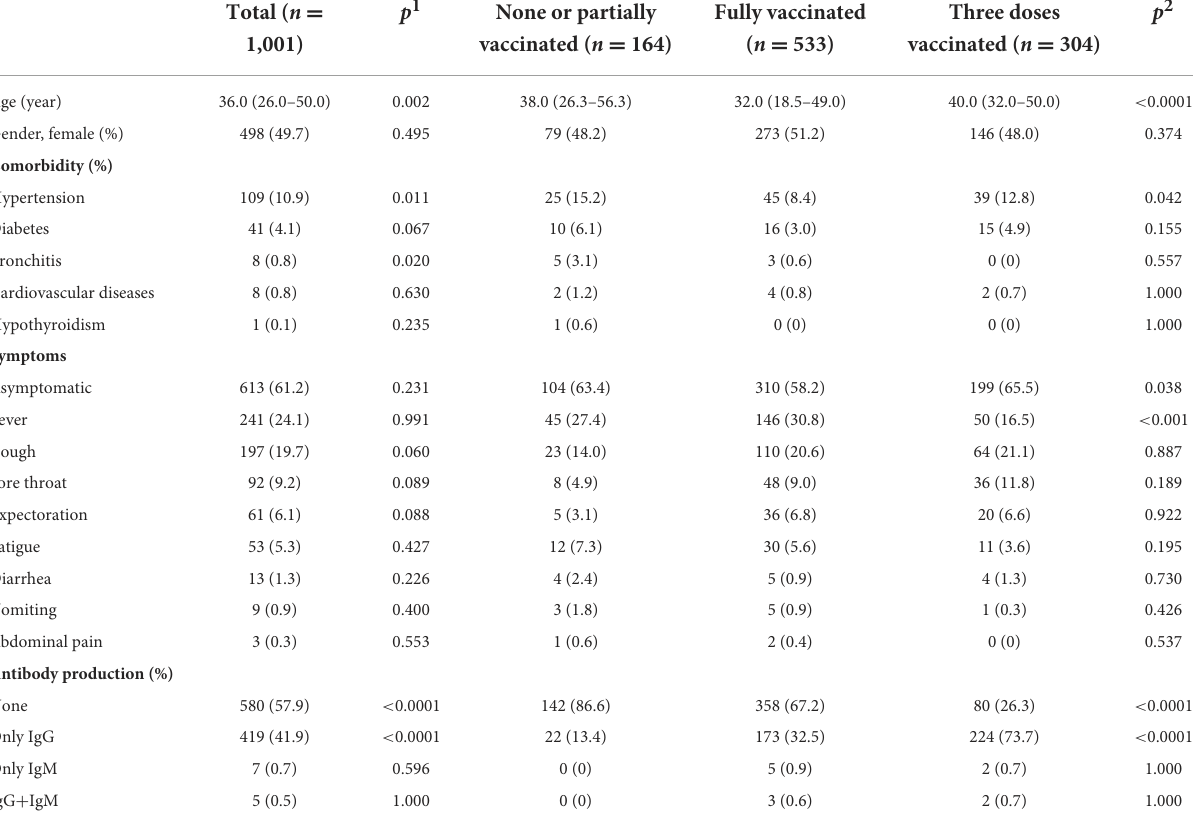
TABLE 1 Demographic information, medical/immunization history, clinical symptom, and antibody production in the COVID-19 patients infected by the omicron variant of SARS-CoV-2. Total ( n = p 1 None or partially Fully vaccinated ( n = 164)